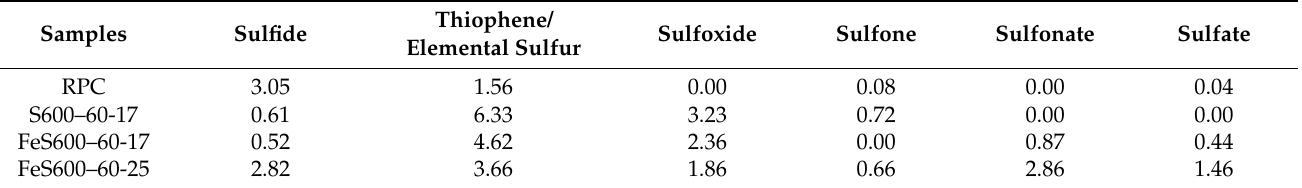
Table 2. Sulfur forms and their absolute content on the surface of RPC, S600–60-17, FeS600 60-25, and FeS600–60-17 (at. %) [45]. Reprinted/adapted with permission from Ref. [45]. 2022, Fuel Processing